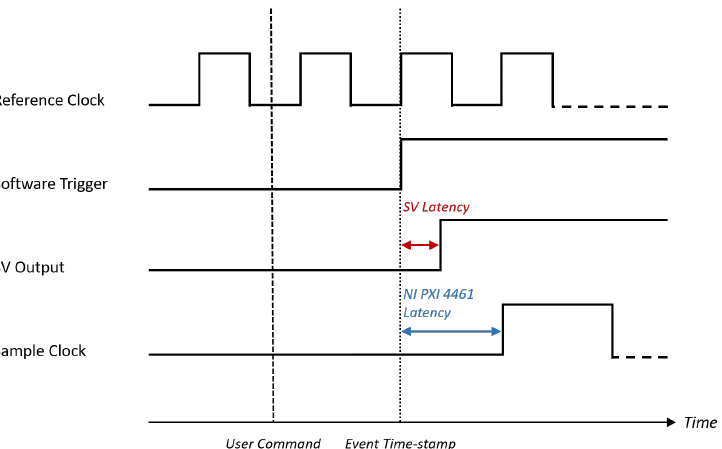
Figure 2. Time reference and trigger organization within the IEC calibrator. The dashed line represents the execution of the user command, whereas the dotted line indicates the occurrence of the future time event corresponding to the selected